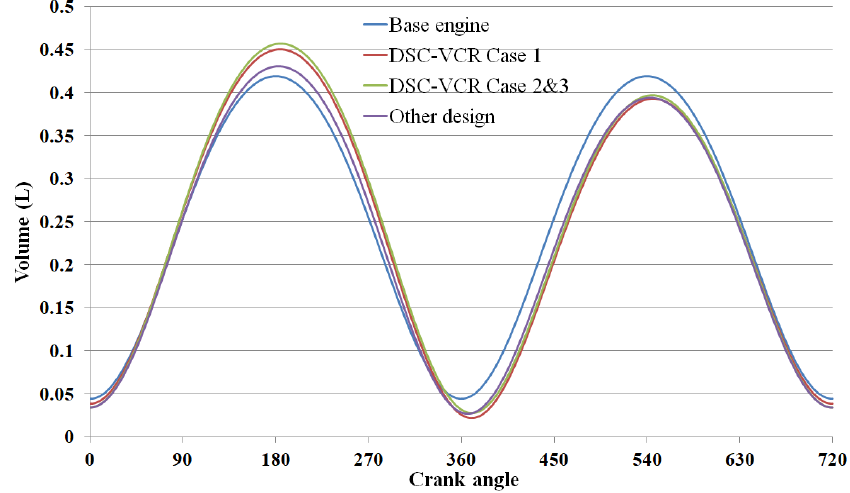
Figure 13. Piston movement for the base engine, the DSC-VCR, and the other design [23].